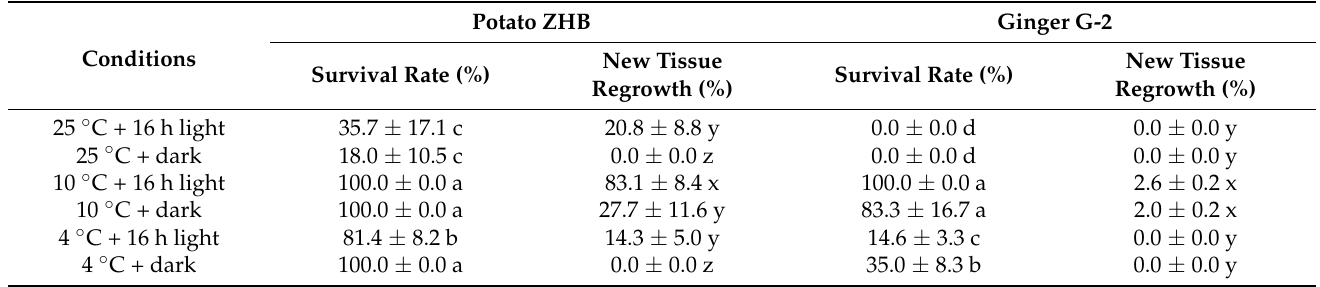
Table 2. Survival and new tissue regrowth of cuttings encapsulated in microplates wrapped in vacuum package under various incubation